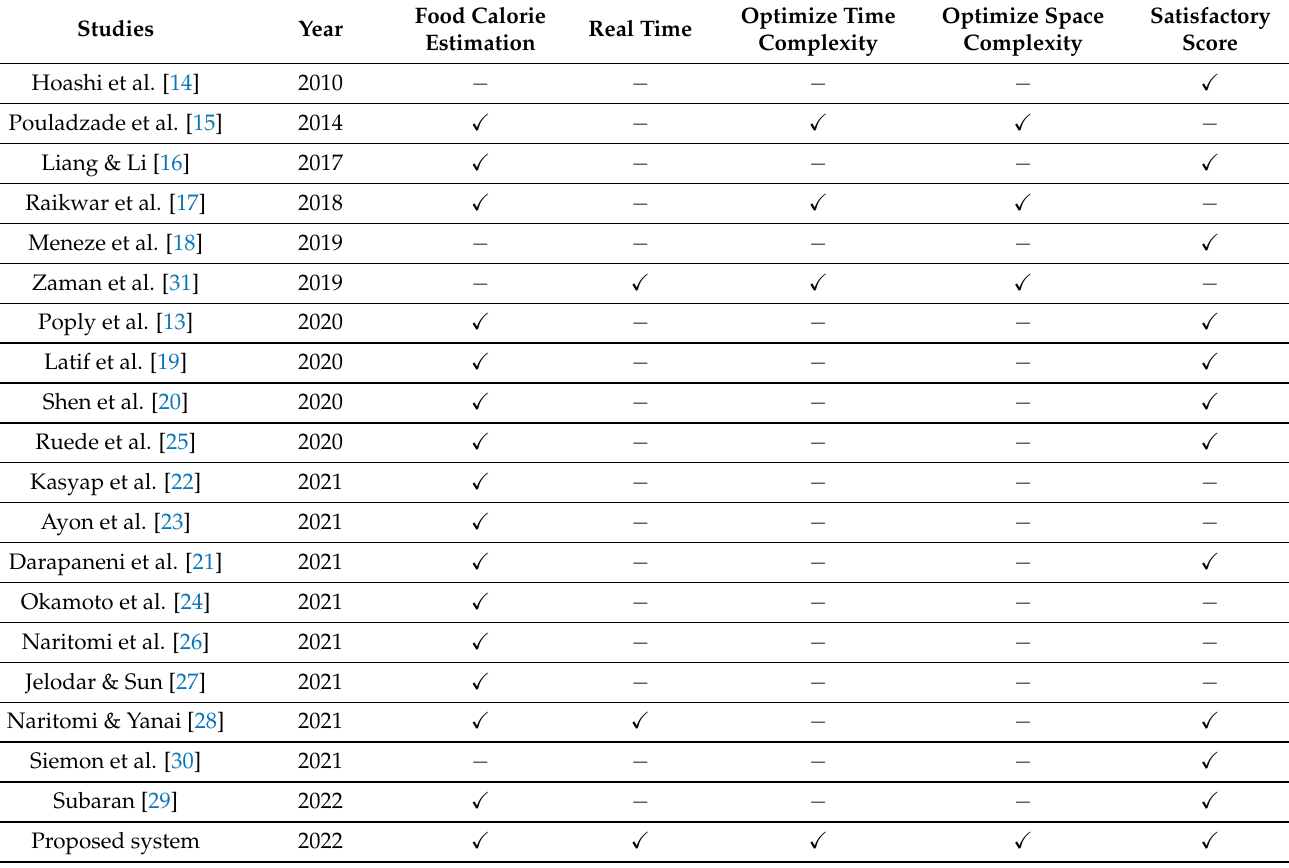
Table 1. Comparative analysis of food calorie systems a